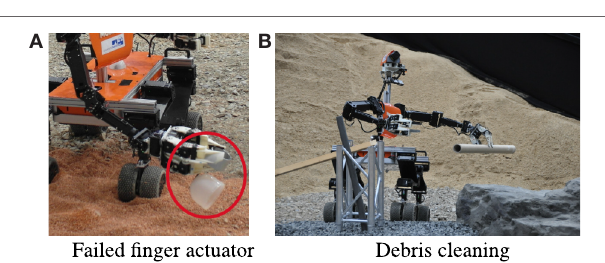
FIGURE 13 | Details of our run at SpaceBot camp . (A) Due to a failed finger actuator, Momaro failed to take the soil sample in the first